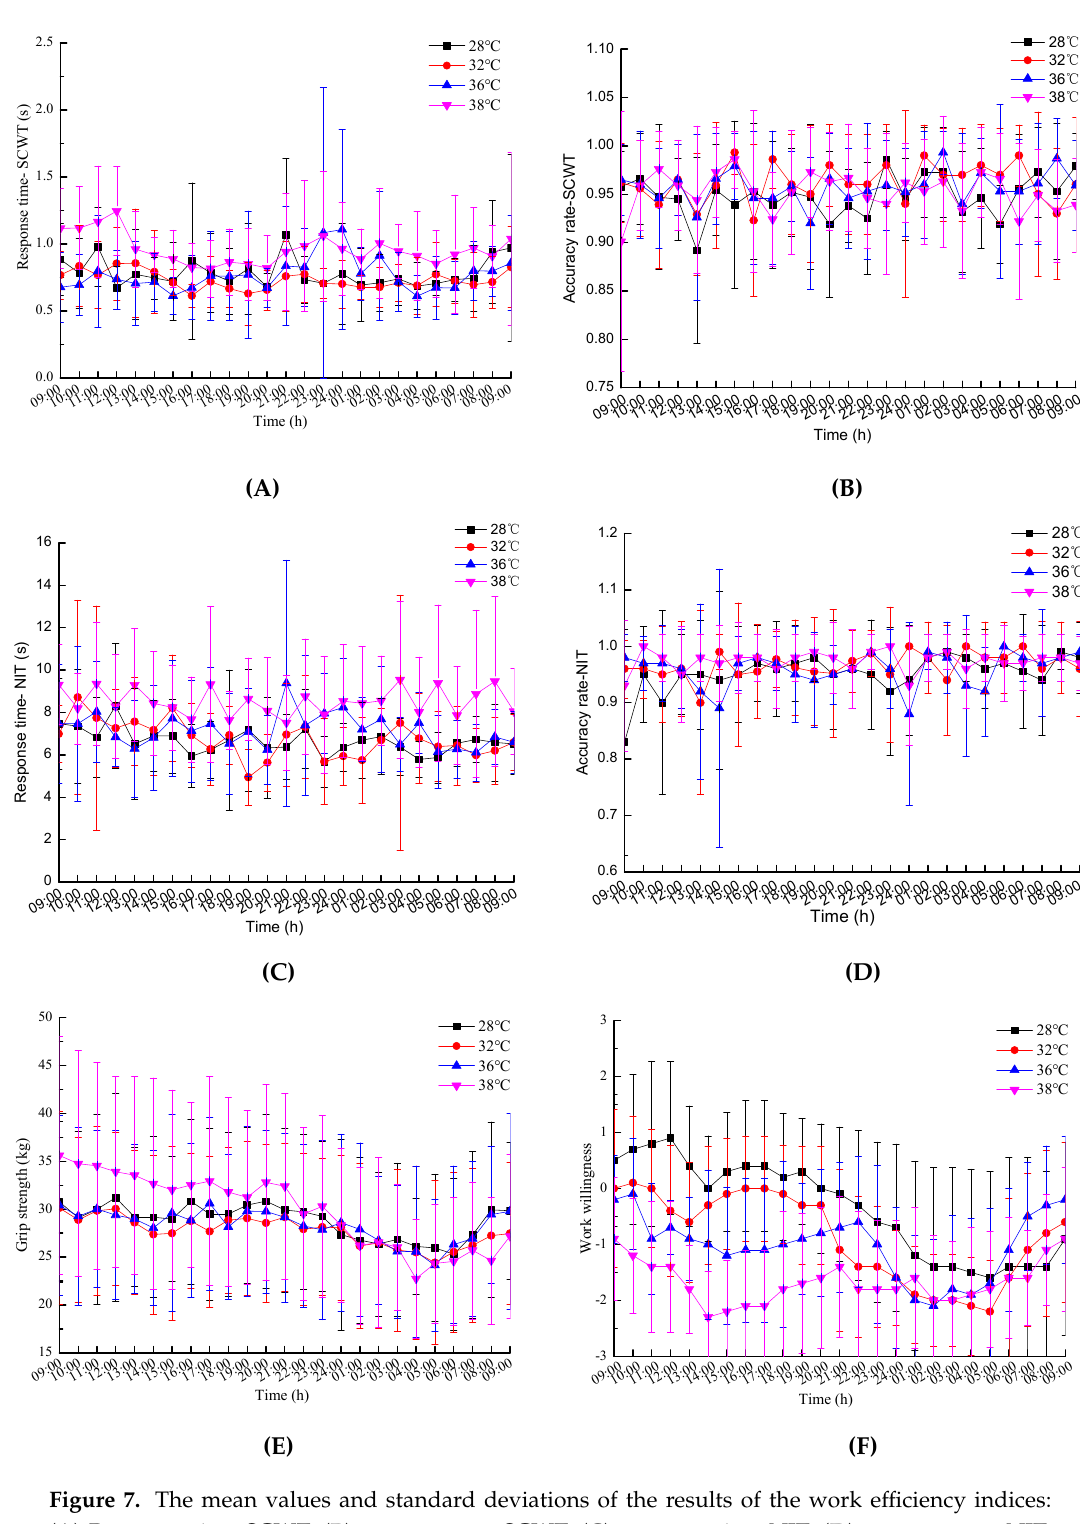
Figure 7. The mean values and standard deviations of the results of the work efficiency indices: ( A ) Response time-SCWT; ( B ) accuracy rate-SCWT; ( C ) response time-NIT; ( D ) accuracy rate-NIT; ( E ) grip strength; ( F ) work willingness.